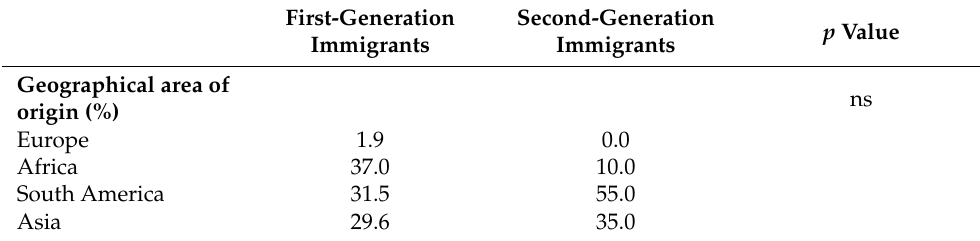
Table 2. Geographical area of origin by migration